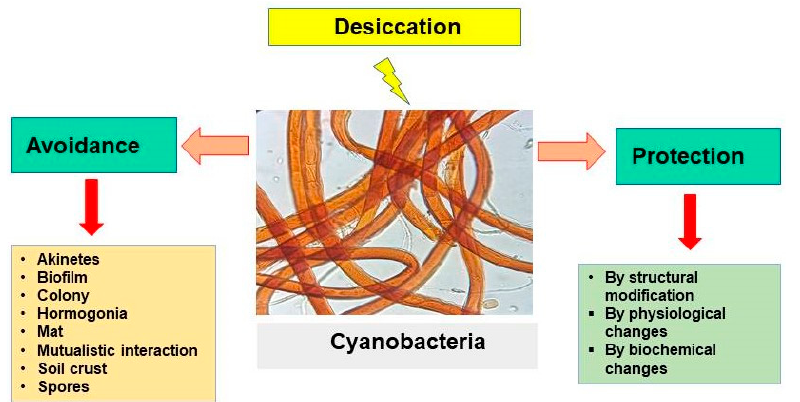
Figure 4. Schematic representation of the general mechanism of desiccation tolerance by cyanobac ‐ teria.